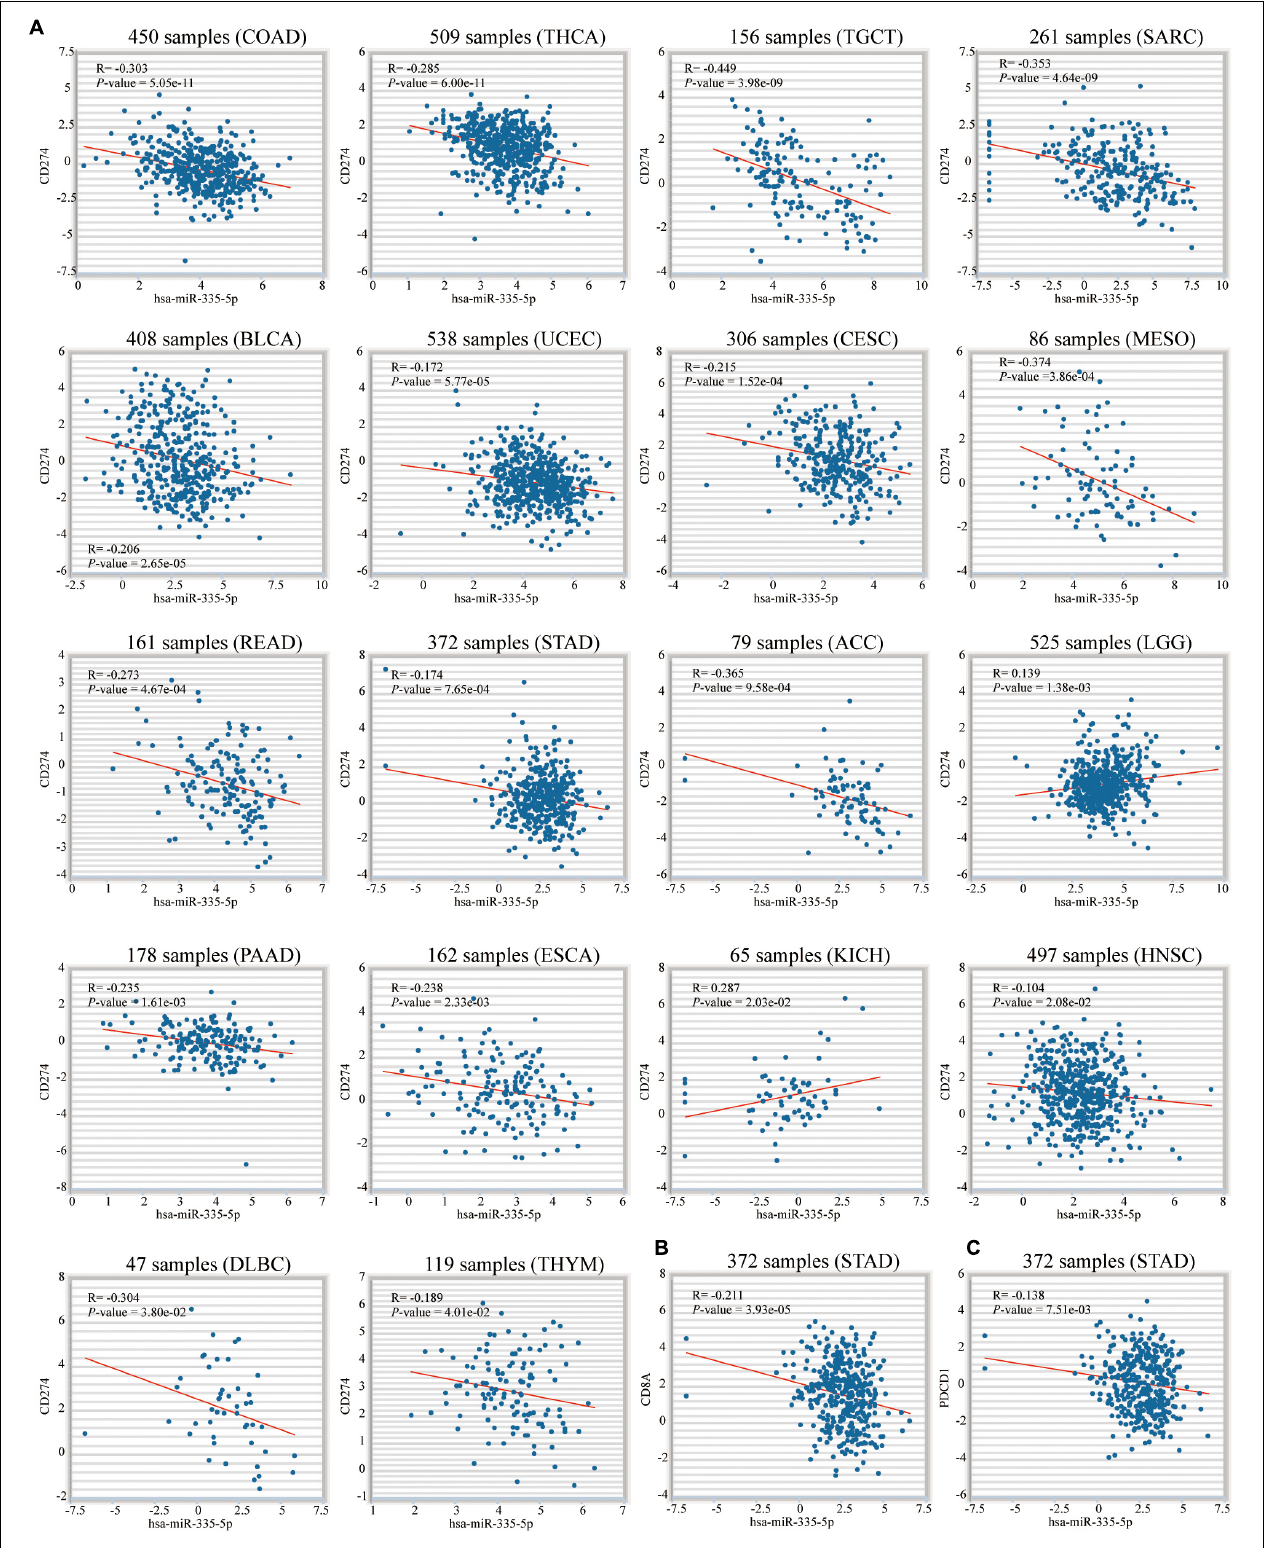
FIGURE 14 | Correlation between hsa-miR-335-5p and PD-L1, CD8A and PDCD1. (A) Among 18 TCGA cancers including STAD, hsa-miR-335-5p was significantly associated with PD-L1. In STAD, hsa-miR-335-5p is significantly related to (B) CD8A and (C) PDCD1.